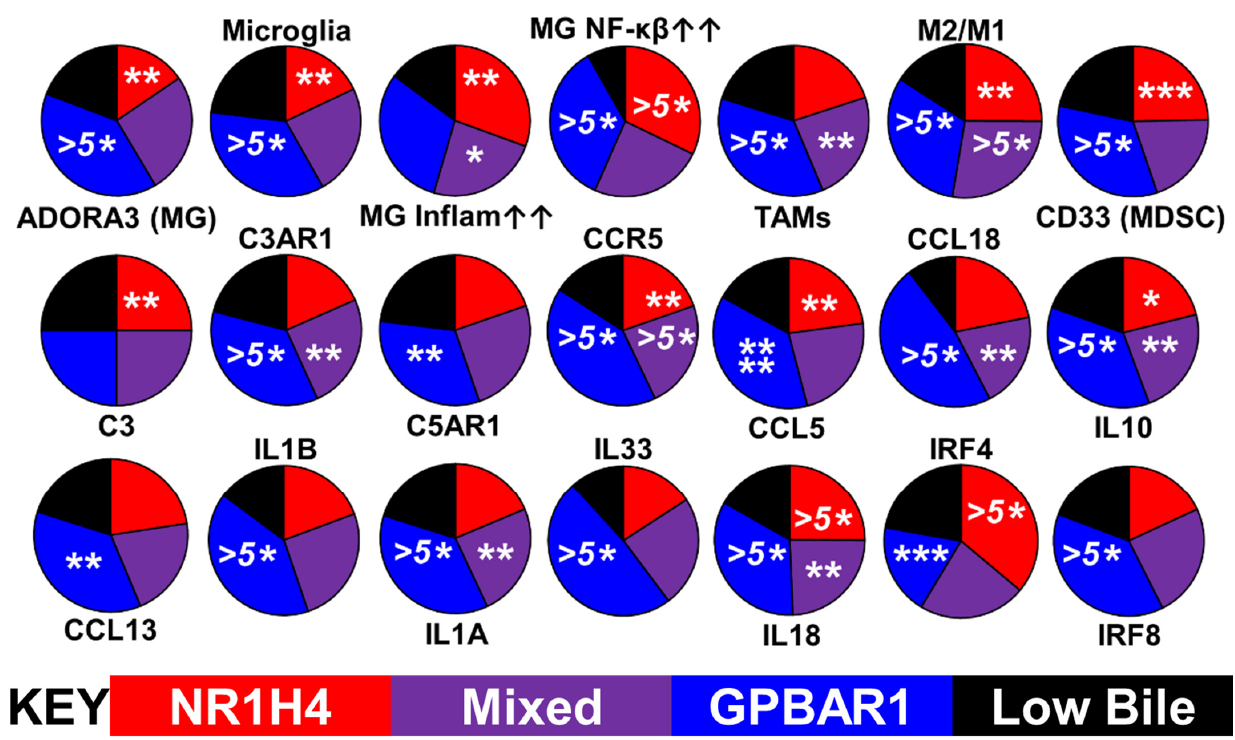
Figure 7. Association of GPBAR1 with the GBM tumor immune type. The GPBAR1-rich tumors are more heavily infiltrated with microglia, TAMs, and MDSCs, which display M2 >> M1 polarization markers. The GPBAR1-expressing subtype shows a distinct overlap with the microglial C3/C3AR1- driven PGD 2 /PGF 2 phenotypes. CCL18, IL10, and CCL13. IL1B, and other members of the IL1 family, including IL33 and IL18, are elevated in the GPBAR1-rich tumors. Interferon regulatory factors 4 and 8 (IRF4 and 8) have a reciprocal relationship with the two bile acid receptors. The GPBAR1 tumors have high IRF8 expression, whereas levels are low in the NR1H4 tumors, but the expression of IRF4 is the opposite in these two tumor types. . Statistical significance from the t ‑tests are represented by asterisks (*), p < 0.05 *, p < 0.01 **, p < 0.005 ***, p < 0.001 ****, and p < 0.0001 (5 * )